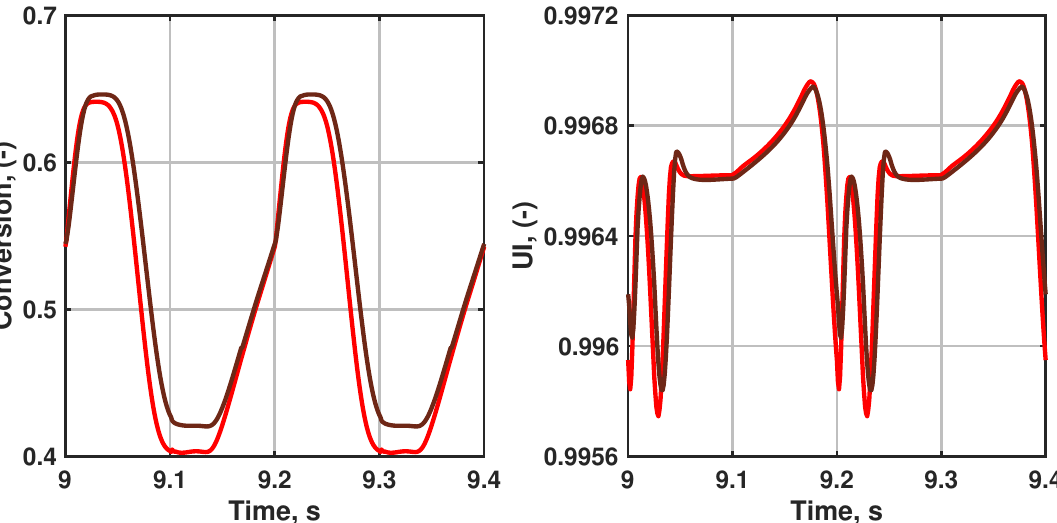
Figure 9. Resulting conversion at the system outlet ( left ) and uniformity index of the reactant field ( right ) over time as obtained in cases 2 (red) and 2B